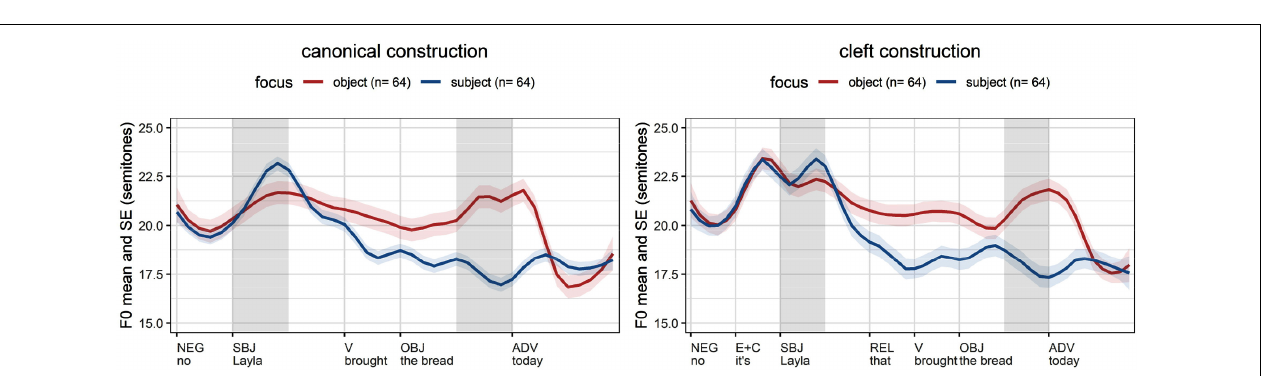
FIGURE 2 | Average f o measurements in British English (time normalization based on five equal intervals per syllable; vertical lines: word edges; gray cells: areas of interest, stressed syllable of subject and